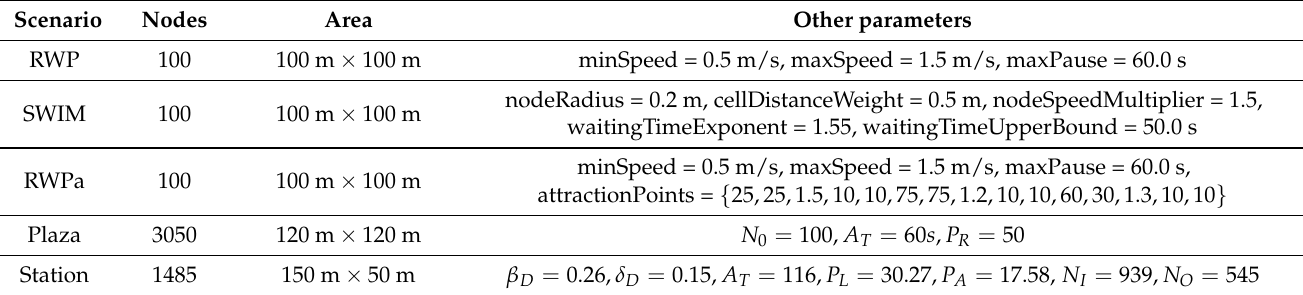
Table 1. Main parameters of the generated